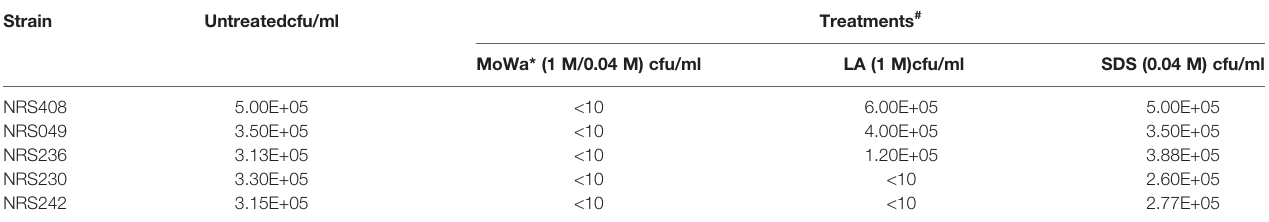
TABLE 3 | Antimicrobial effect of MoWa (MIC 90 ), levulinic acid or SDS. Strain